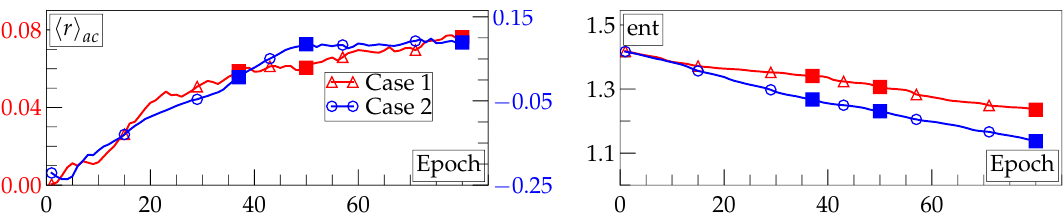
Figure 4. ( Left ) Evolution of the reward value averaged over the action time step training (random policy); and ( Right ) random policy entropy decrease during the optimization process. Square points on both sets correspond to Epochs 37, 50 and